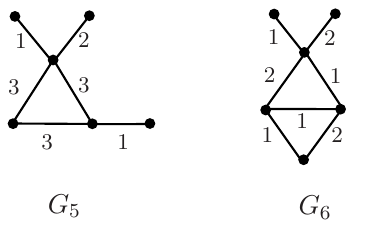
Figure 3. The graphs G 5 and G 6 with a proper-path